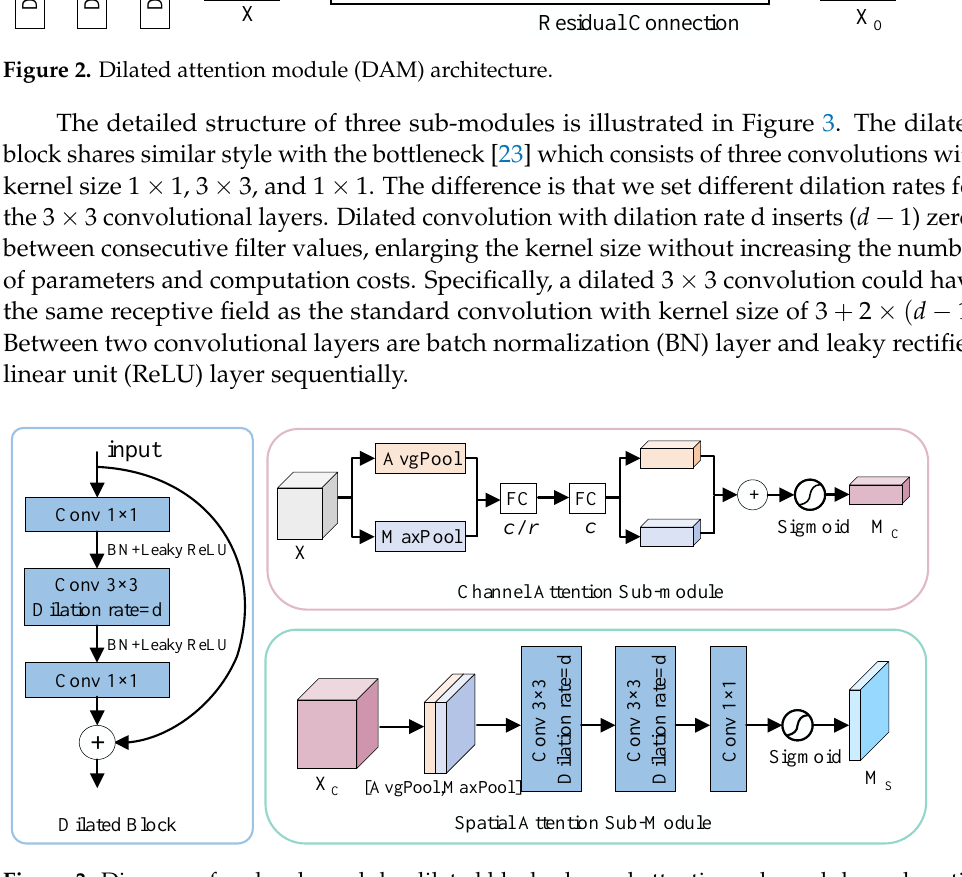
Figure 3. Diagram of each sub-module: dilated block, channel attention sub-module, and spatial attention